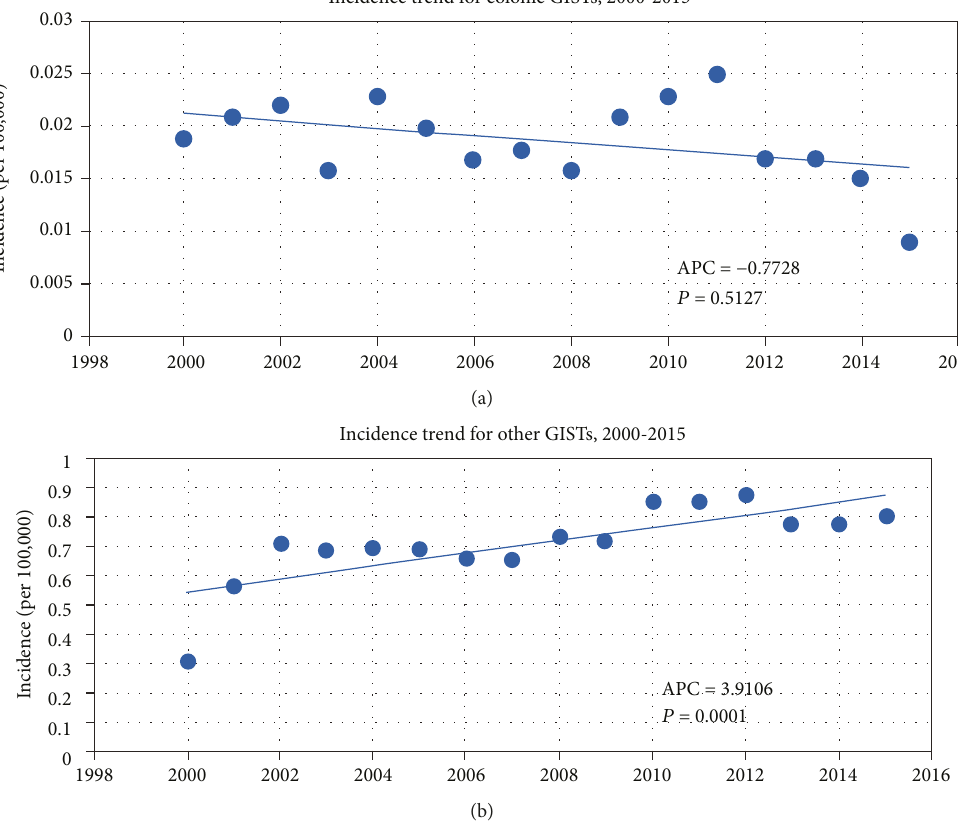
Figure 2: Incidence trend for colonic GISTs and other GISTs. Table 3: Therapy for colonic GISTs and other